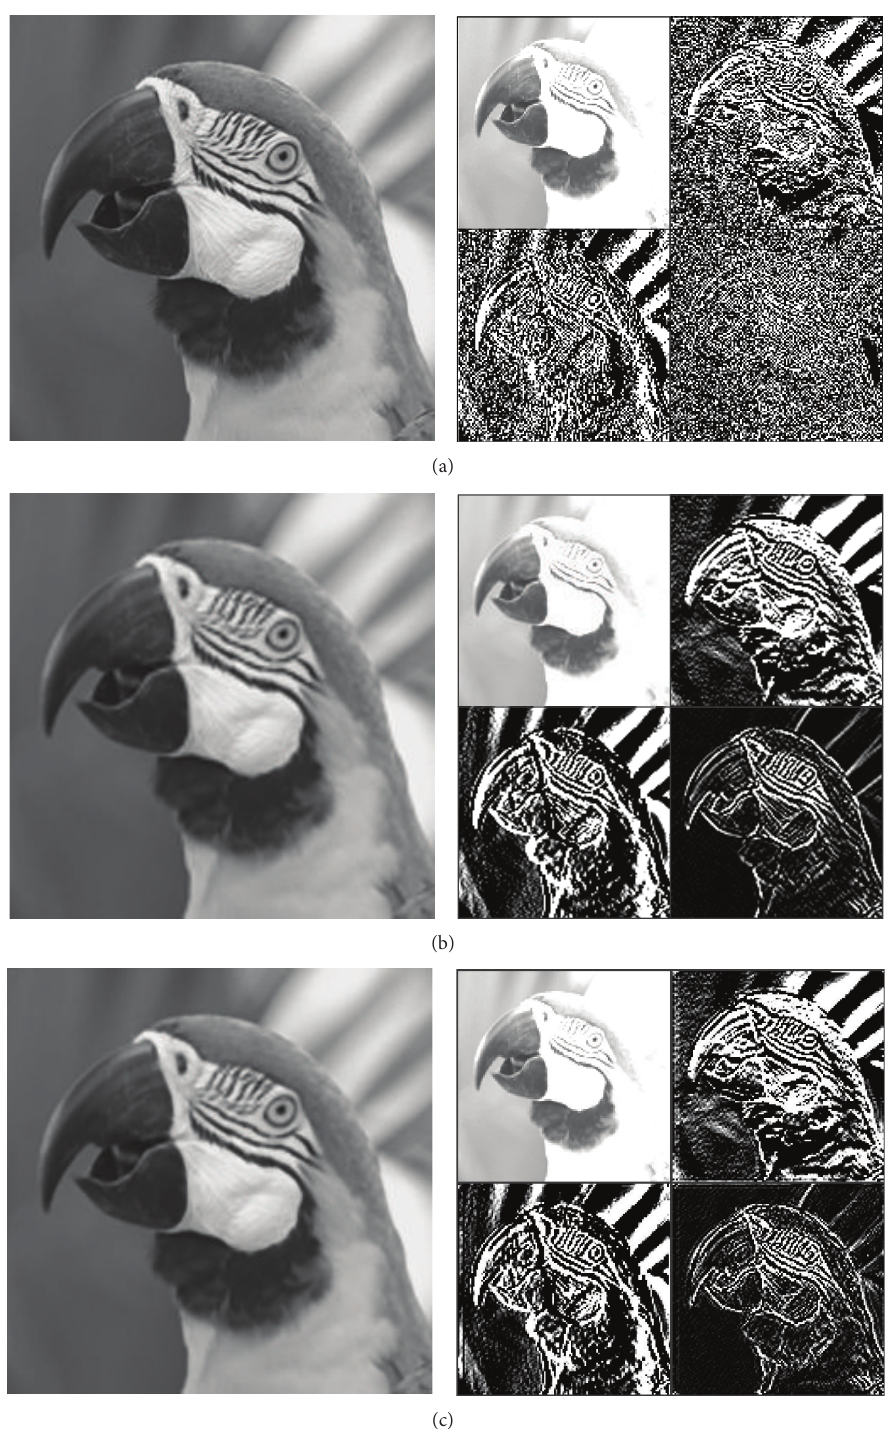
Figure 1: The images and their corresponding decomposition images after 1-level DWT (the subimages contain an approximation subband and three detail subbands). (a) The ground HR parrot image and its decomposition images. (b) The bicubic interpolated image and its DWT subband images. (c) The HR image reconstructed by our method and its DWT subband